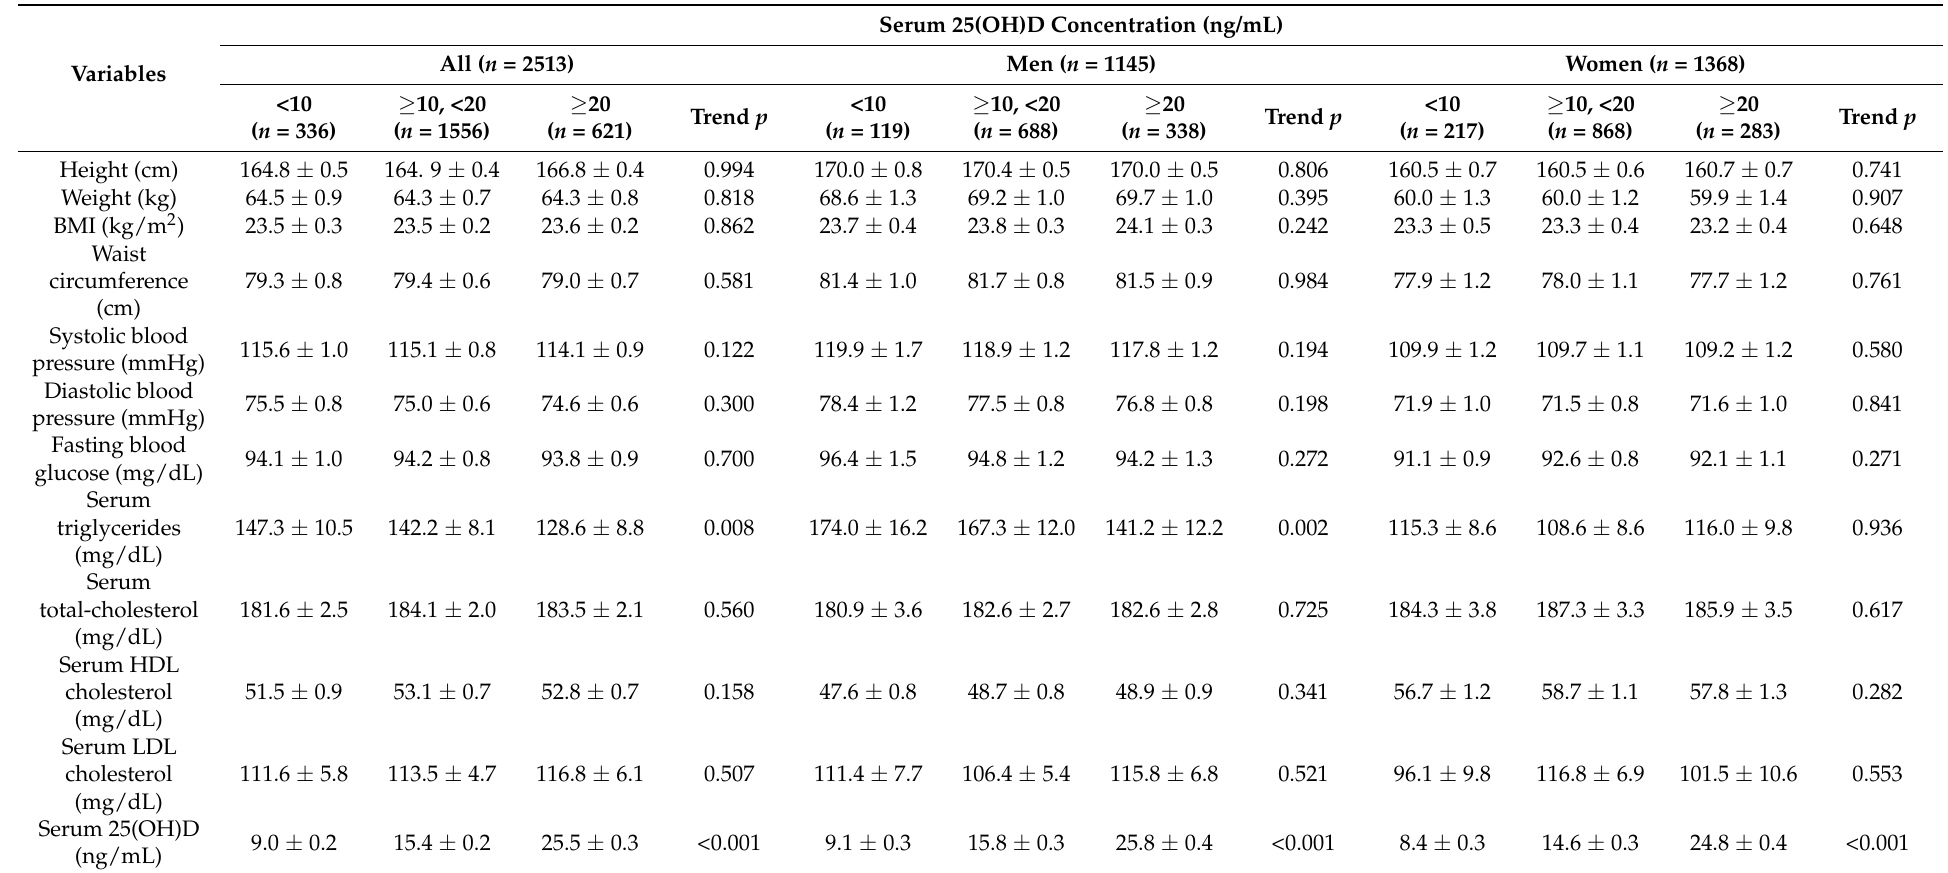
Table 3. Anthropometric and biochemical measurements of the participants by categories of serum 25-hydroxyvitamin D (25(OH)D) concentration and